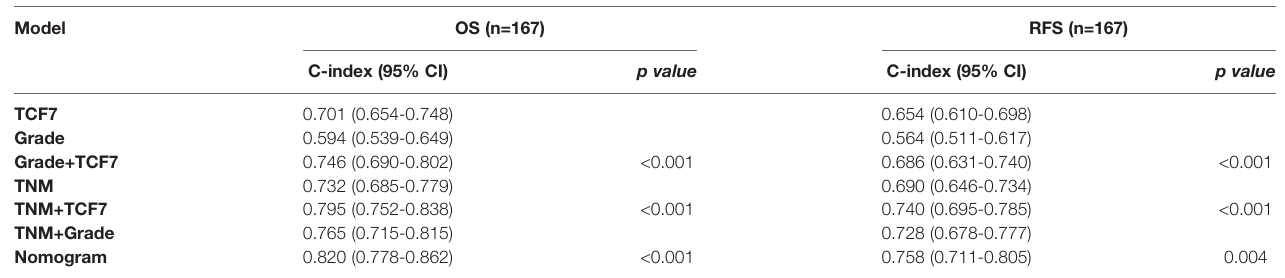
OS, overall survival; RFS, recurrence-free survival; C-index, concordance index; CI, con fi dence interval. A higher c-index indicates better